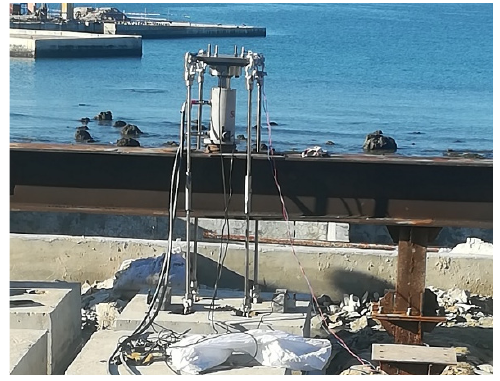
Figure 7. Vertical loading device for simulation test.